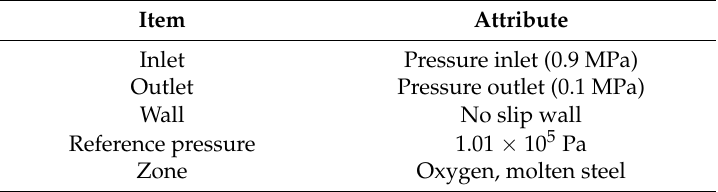
Table 3. Boundary conditions of the numerical model